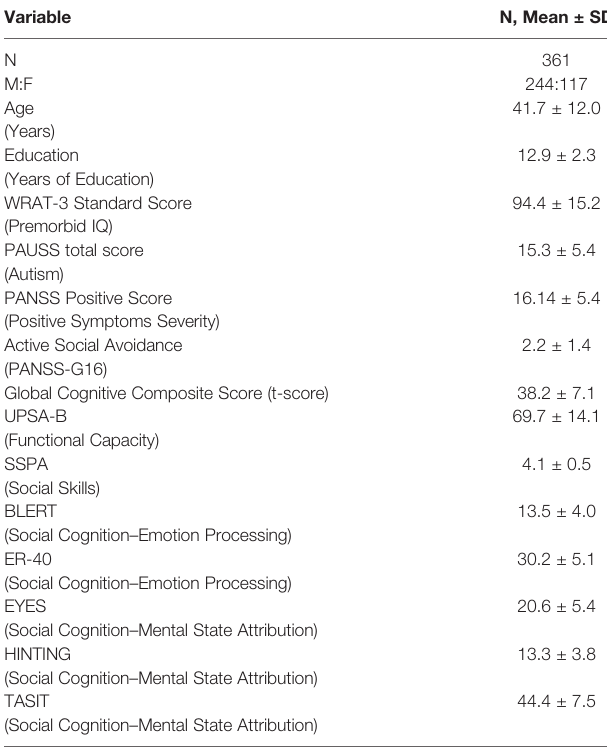
TABLE 1 | Characteristics of the